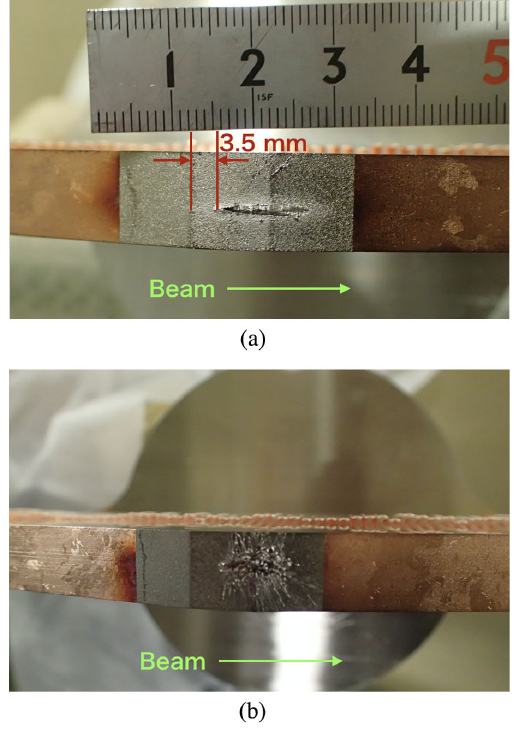
FIG. 16. Photograph of a damaged jaw in (a) a top side and (b) a bottom side of the D06V2 collimator. The traveling direction of the beam is from left to right in this photograph.